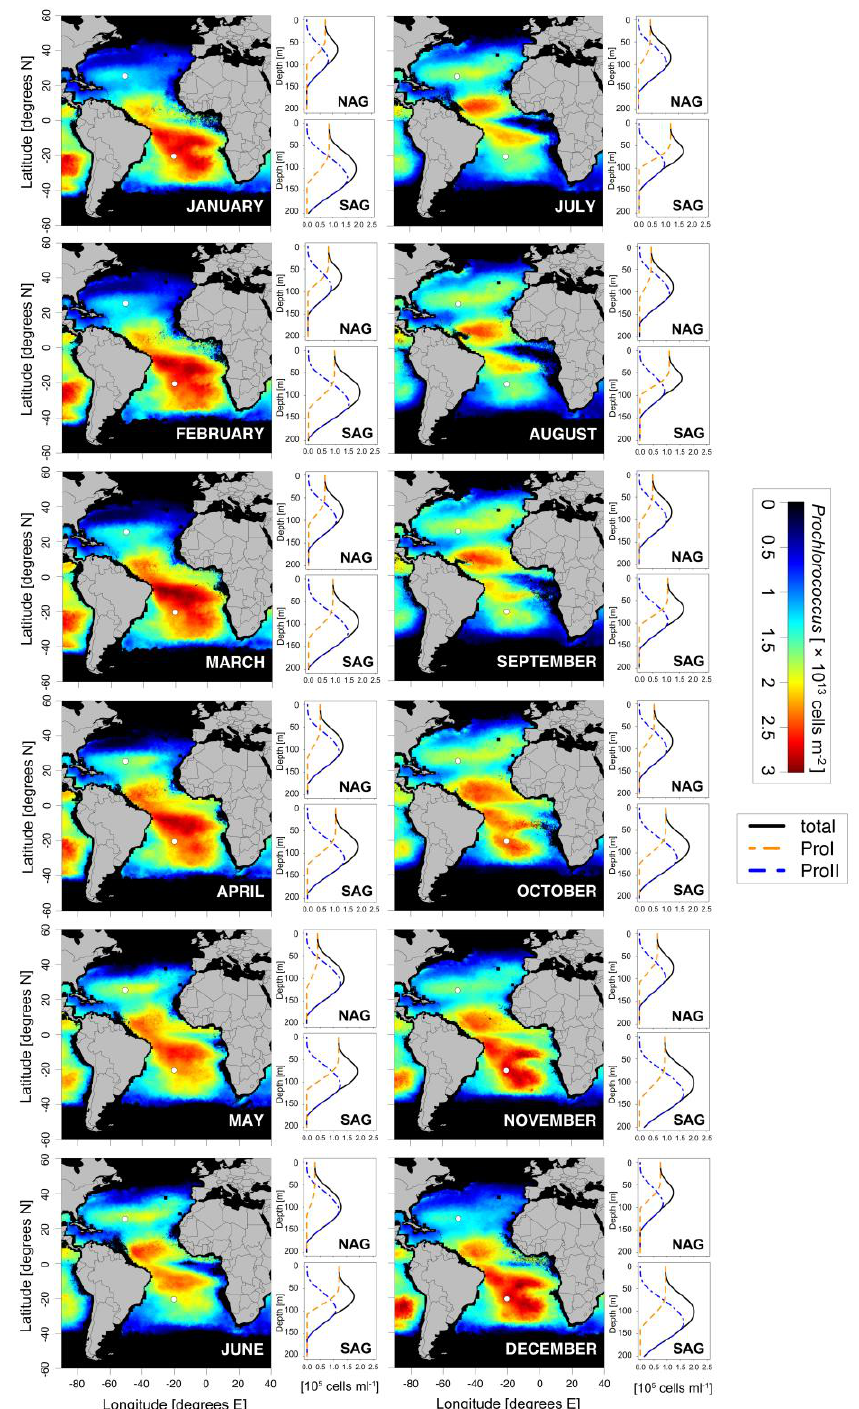
Figure 8. Estimated monthly distribution of the Prochlorococcus cells integrated in the top 200 m of the water column ( Pro int ) (cells m −2 ), with correspondent vertical profiles of estimated Prochlorococcus cell abundance (cells l −1 ) at sites (white dots) in the North Atlantic Gyre (NAG) and South Atlantic Gyre: ProI ( z ) is indicated by the orange dashed line, ProII ( z ) by the blue dashed line, and the total Prochlorococcus abundance by the solid black line. Cell abundance was calculated based on the monthly climatology of environmental variables [22].